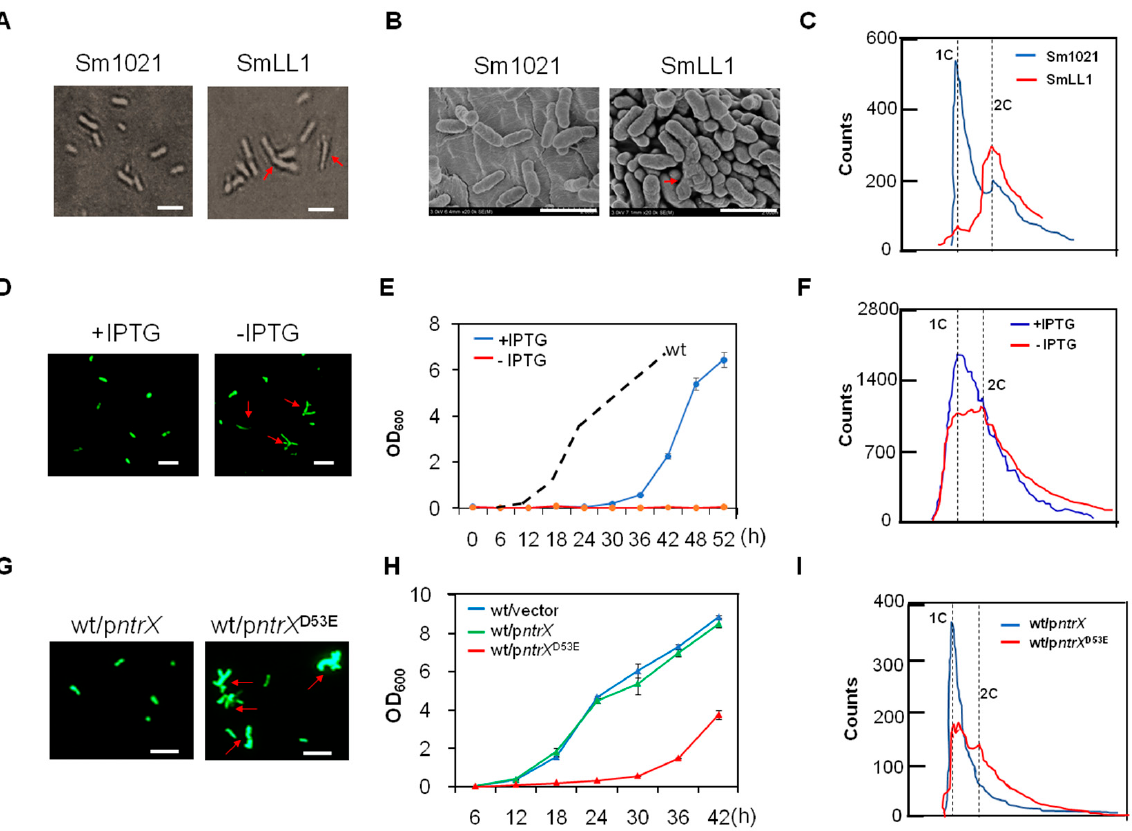
Figure 1. Cell division defects of S. meliloti ntrX mutants in LB/MC broth. ( A , B , D , G ) Cell morphology and sizes of ntrX mutants under a light, scanning electron or fluorescence microscope. Red arrows, abnormal cells; bars, 2 µ m. Sm1021 and SmLL1 cells were grown in LB/MC broth to logarithmic phase in ( A , B ). The depletion cells ( ∆ ntrX /p ntrX ) carrying pHC60 [39] were grown in LB/MC broth with or without 1 mM IPTG for two hours in ( D ). The cells of Sm1021/p ntrX and Sm1021/p ntrX D53E carrying pHC60 were grown in LB/MC broth containing 1 mM IPTG for two hours. ( C , F , I ) Genomic DNA content of ntrX mutants was determined by flow cytometry. 1C, haploid; 2C, diploid. Synchronized cells of Sm1021, SmLL1, Sm1021/p ntrX, and Sm1021/p ntrX D53E were grown in LB/MC broth for three hours in ( C , I ). The latter two strains were also incubated with 1 mM IPTG in ( I ). The depletion cells were grown in LB/MC broth with or without 1 mM IPTG for one hour in ( F ). ( E , H ) Growth curves of the ntrX depletion strain and Sm1021/p ntrX D53E in LB/MC broth with 1 mM IPTG. Error bars, ±SD.